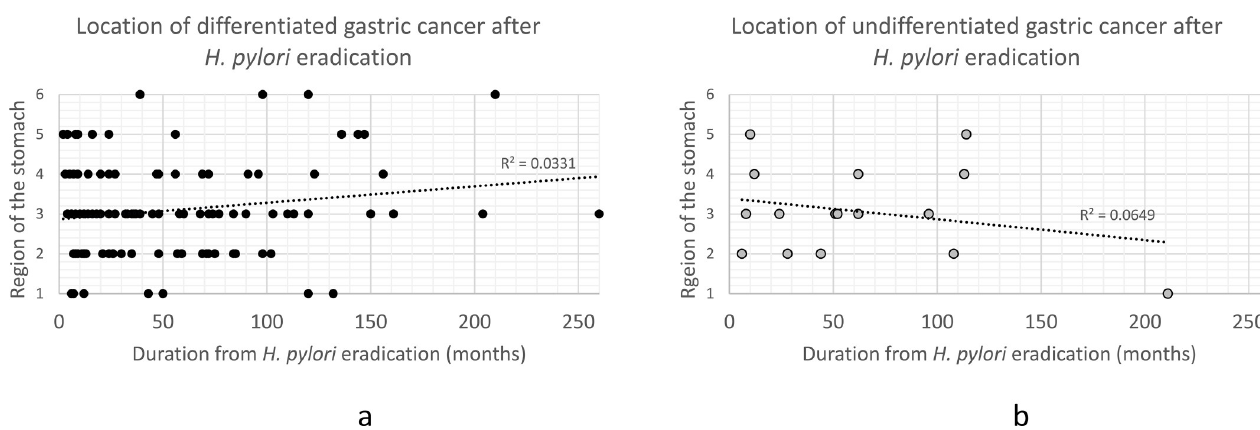
Fig 4. Gastric cancer incidence by time after eradication. Differentiated gastric cancer tended to occur on the U side (a), while undifferentiated gastric cancer tended to occur towards the L side after HPE (b). There was no significant trend in the location of gastric cancer over time in each group.